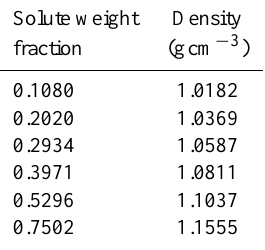
Table 2. Density of 2-methylglutaric acid solutions in water. All measurements carry an error of 1 . 5 × 10 − 3 gcm − 3